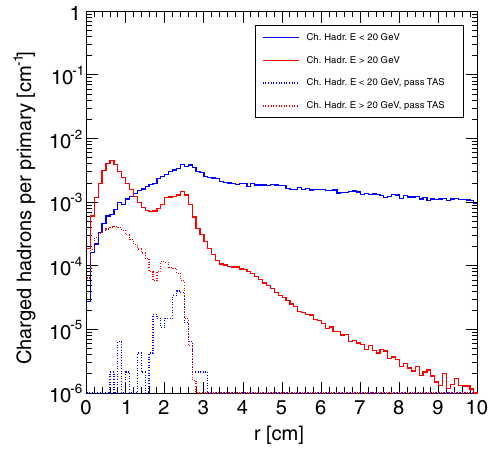
FIG. 11. Radial distributions of charged hadrons crossing the interface plane close to the beam line, as simulated with F LUKA for beam-halo losses on the TCTs assuming the 2015 machine optics with β (cid:1) ¼ 80 cm. The solid histograms show the totals in two energy ranges, while the dotted ones correspond to particles which, using a straight extrapolation of the trajectory, pass the TAS aperture but cross the beam-pipe wall upstream of the BCM detector. The histograms are normalized per radial unit in order to give a better impression of the number of particles at any given shows the distribution of high-energy muons, which are susceptible to produce fake jets in the ATLAS calorimeters.